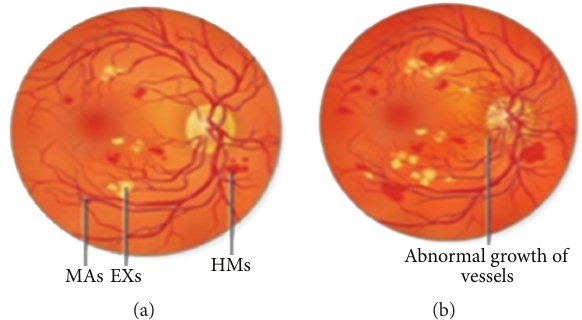
Figure 1: Stages of diabetic retinopathy. (a) Signs of NPDR. (b) Signs of